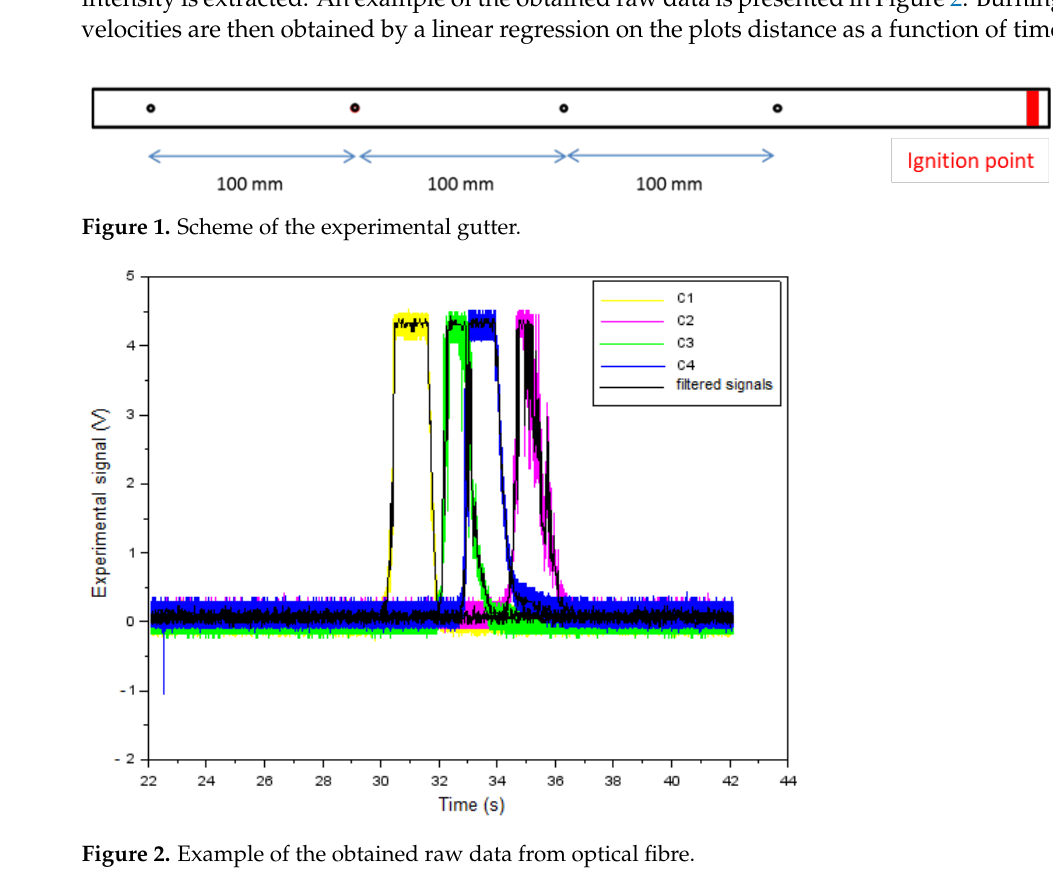
Table 3. Measured binary compositions burning velocities with associated experimental masses and porosities.